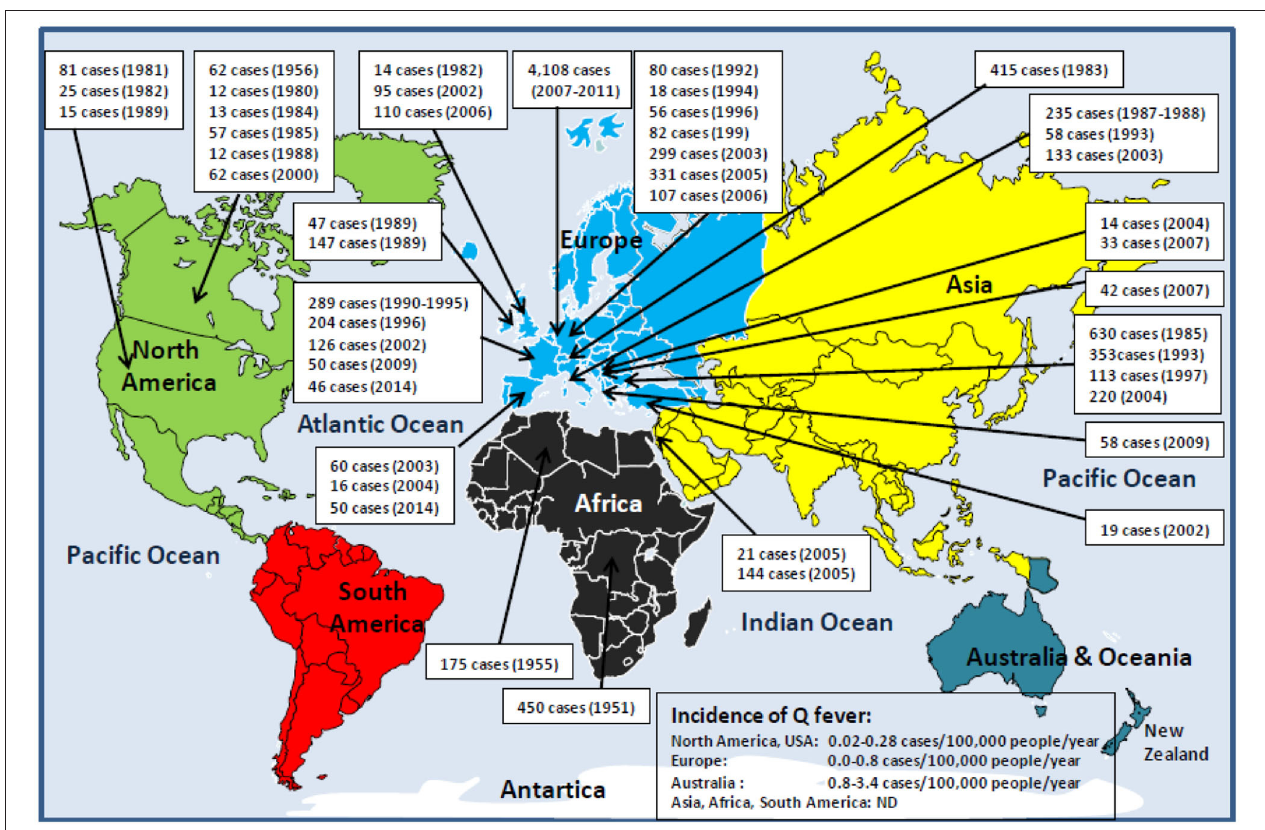
FIGURE 1 | Schematic representation of human Q fever epidemiology around the world. With the exception of Antarctica and New Zealand, Q fever is a global zoonosis present in North America, South America, Europe, Asia, Africa, and Australia/Oceania. The clinical manifestation of Q fever in human is usually an undifferentiated febrile illness. Q fever was described for the first time in humans in 1937 by Burnet, who investigated several cases of Australian abattoir workers suffering from undifferentiated febrile illness (15, 16). During the Second World War (1941–1944), the Q fever disease was reported among German soldiers stationed in the Balkans, Southern Italy, Corsica, in English and American allied troops in Central Italy, and soldiers in Crimea and Ukraine. That is why the disease has had many synonyms: Olympus fever, Crimean fever, flu Balkan flu, Cretan pneumonia, Euboea fever, fever of the 7 days, or Derrick and Burnet’s disease ( 17). The causative agent of the disease first identified by Cox in the United States, and formerly named Rickettsia diasporica , was definitively renamed Coxiella burnetii ( 18–20). The figure illustrates the history of the major human epidemics of Q fever (outbreaks > 10 linked cases) from 1950 (when the Third World Health Assembly passed a resolution calling for study of the prevalence of Q fever throughout the world) to the present day. Although C. burnetii infection has been classified as a notifiable animal disease by the World Organization for Animal Health, OIE (14), the lack of mandatory reporting of human Q fever cases in most countries, the predominance of asymptomatic forms, the clinical polymorphism, and the difficulty of diagnosis are likely to lead to a significant underestimation of the true incidence of the disease in humans. In Europe where the ECDC carries out a regular epidemiological surveillance, only 1,023 of 4,245 Q fever cases confirmed during the 2013–2017 period were reported by the European countries ( 21). It is impossible to evaluate the number of cases for the Asian and African continents. ND, not